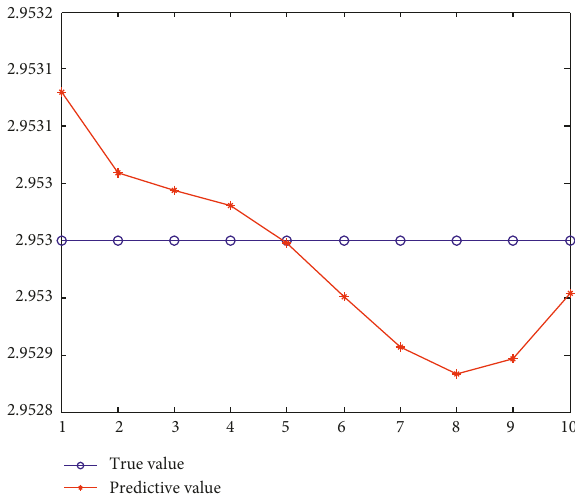
Figure 11: Comparison of BP-predicted and real values.